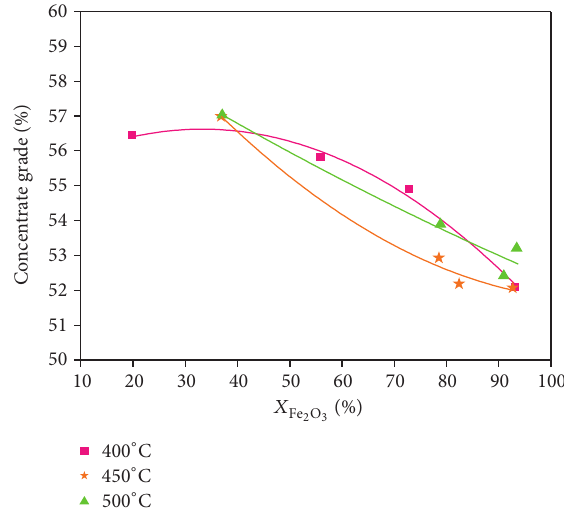
Figure 14: Effect of current strength on the concentrate grade.